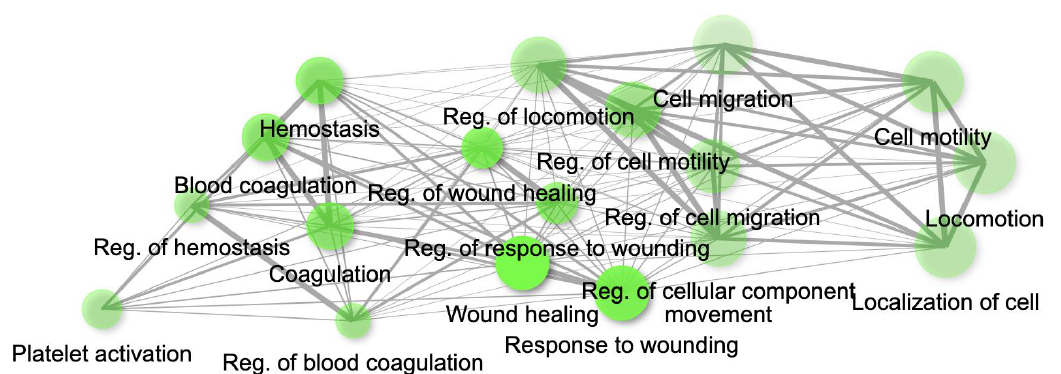
Figure 13. Dot plot for top 20 enriched pathways based for gene module, MEcyan based on KEGG.